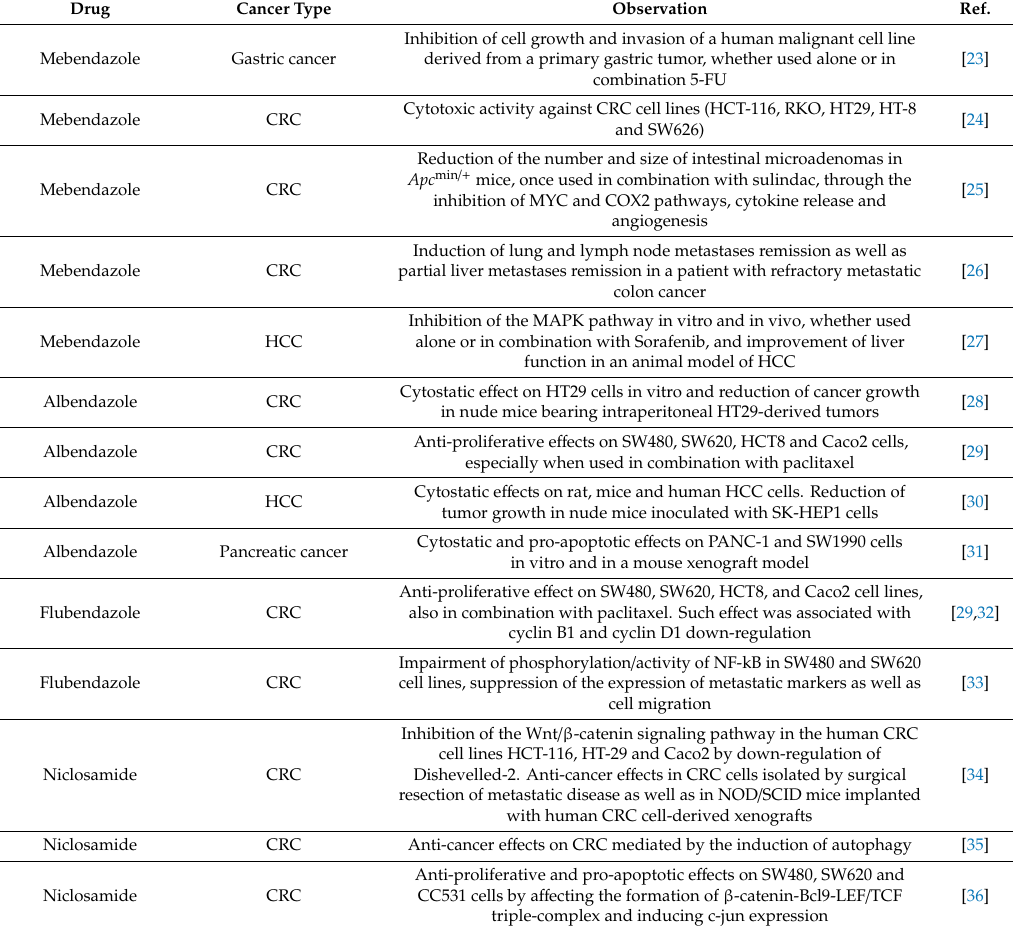
Table 1. Anti-tumor e ff ects of anthelmintic drugs in malignancies of the digestive apparatus. Drug Cancer